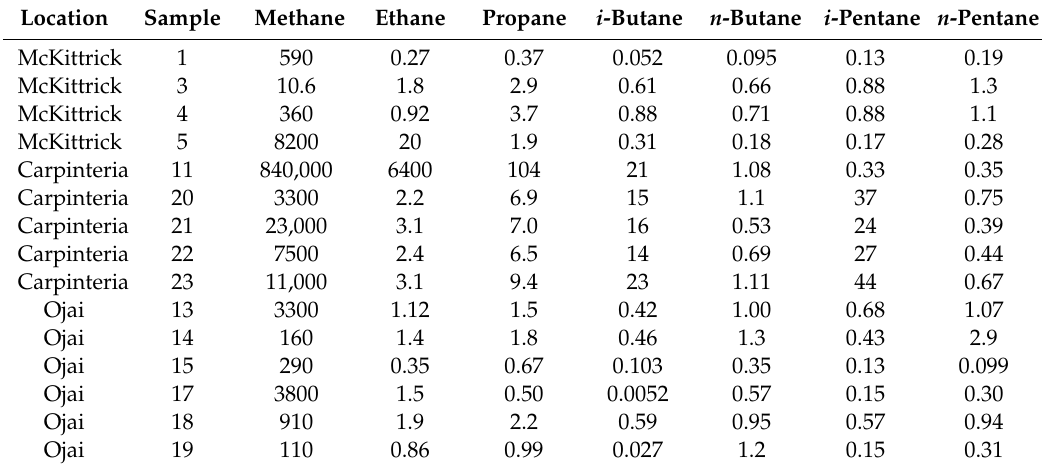
Table 1. Flux magnitudes by mass ( µ g / h) for each of the fifteen positive-flux seeps that were sampled in this study.